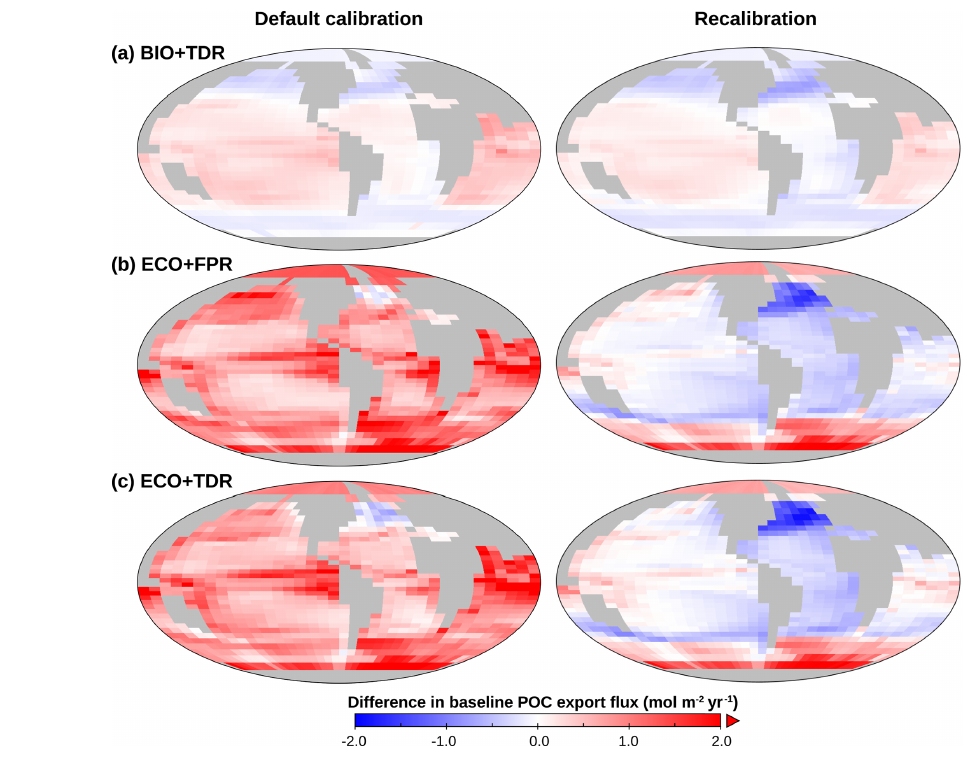
Figure 4. cGEnIE and ecoGEnIE POC export maps, showing changes in baseline for BIO+TDR (a) , ECO+FPR (b) , and ECO+TDR (c) in the default calibration (left) and recalibrations (right) relative to the default BIO+FPR configuration (Fig. 3a, left). Plot created with Panoply, available from NASA Goddard Space Flight